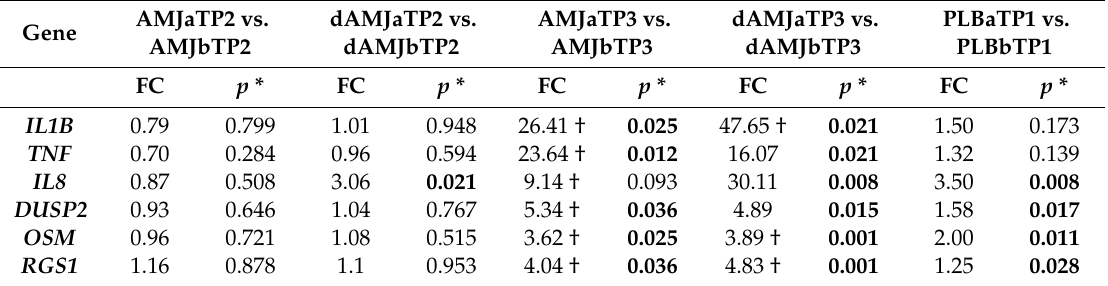
Table 3. The candidate genes’ expression changes in peripheral blood mononuclear cells of the study subjects, during di ff erent treatment periods, observed by